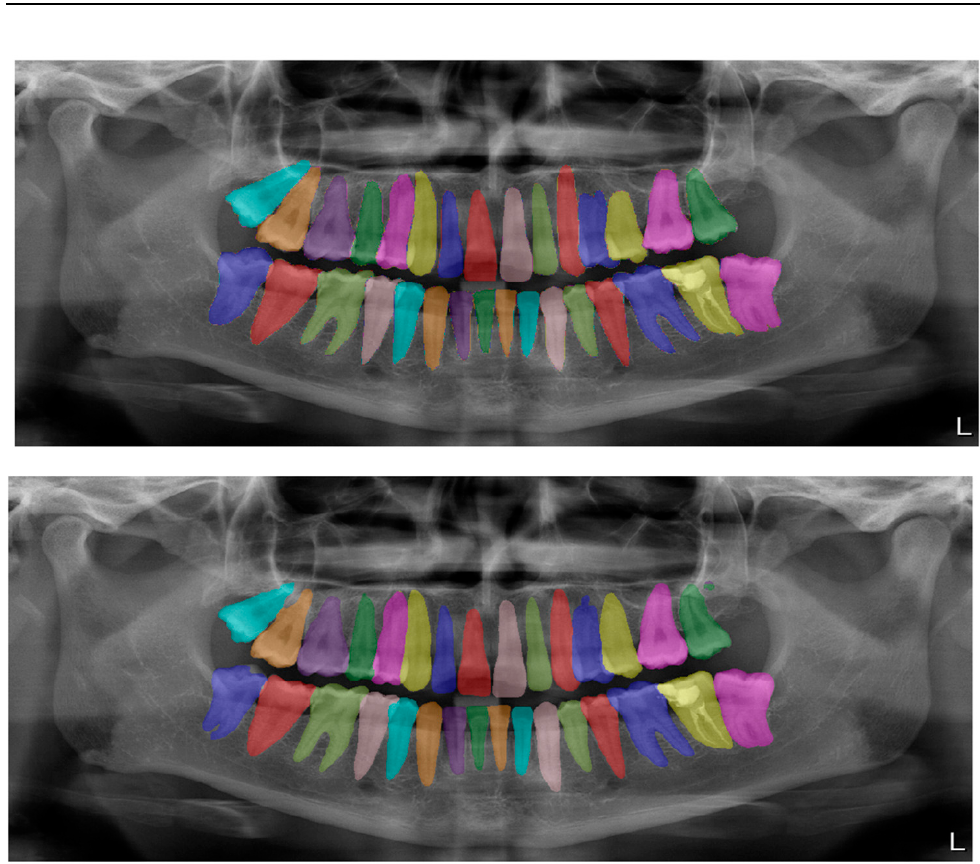
Figure 2. Automatic segmentation of the teeth. Manual segmentation ( upper image ) and automatic segmentation ( lower image ) can be seen above. Each tooth has a unique label according to FDI World Dental Federation